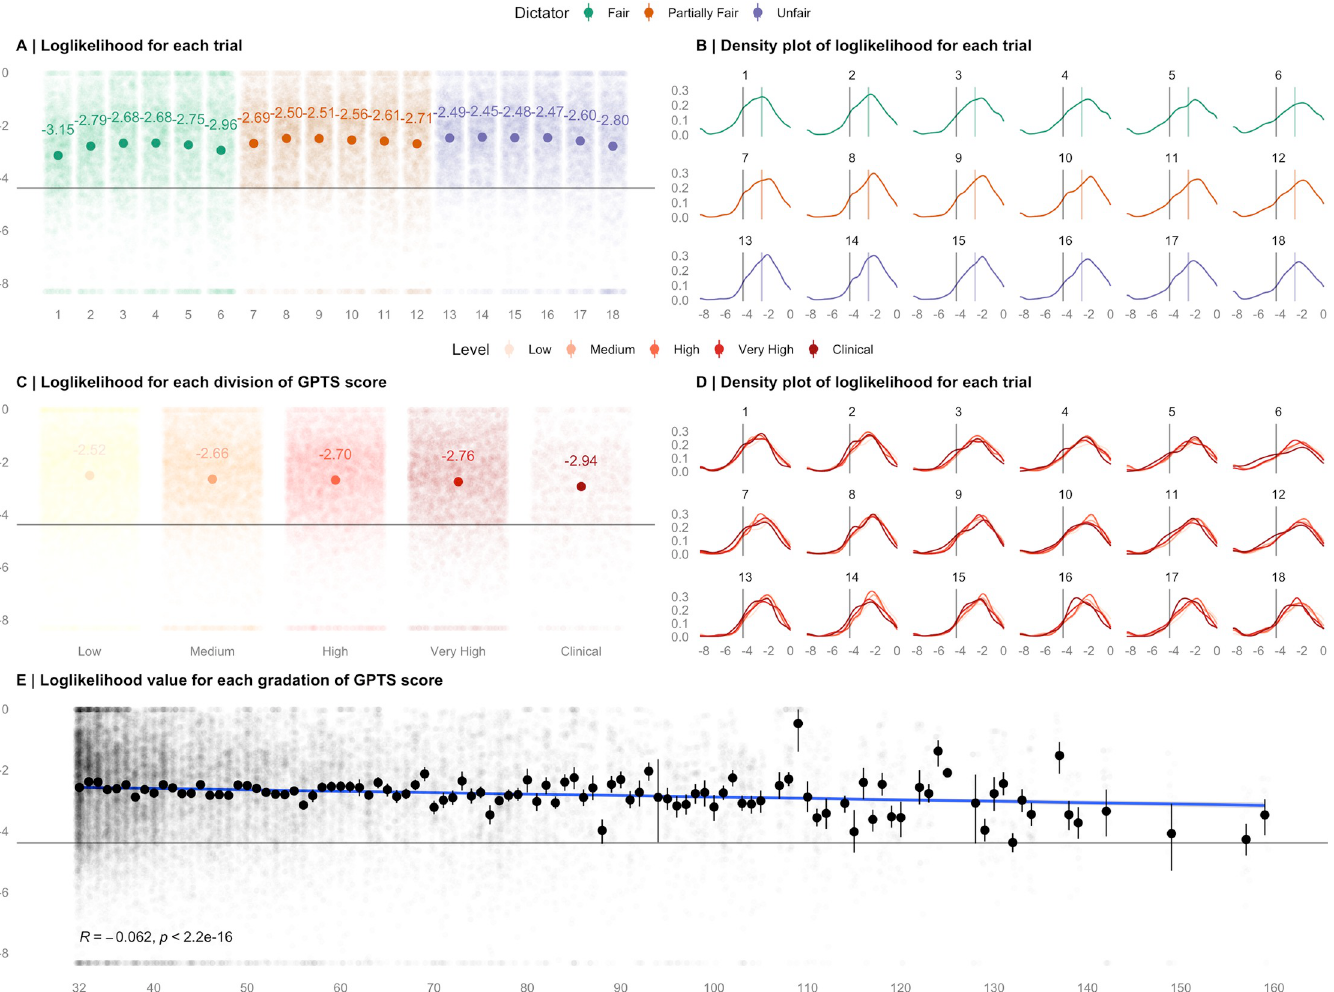
Fig 1. Log Likelihood values of the model. (A) Computed mean log likelihoods for each trial, coloured by dictator type. (B) Density plots of log likelihood values for each trial, coloured by dictator type. Coloured lines represent group means (C) Computed mean log likelihoods for each GPTS score quantile and clinical score cut off (Green et al., 2008). (D) Density plots of log likelihood values for each trial across each GPTS score quantile and clinical score cut off (Green et al., 2008). (E) The association between GPTS scores (minimum score = 32) and loglikelihood values. Dots = mean loglikelihood value across that score of the GPTS. Lines = 95% confidence intervals. The grey line in each plot (at -4.394) represents the loglikelihood that would be observed if the model was capturing behaviour by chance.